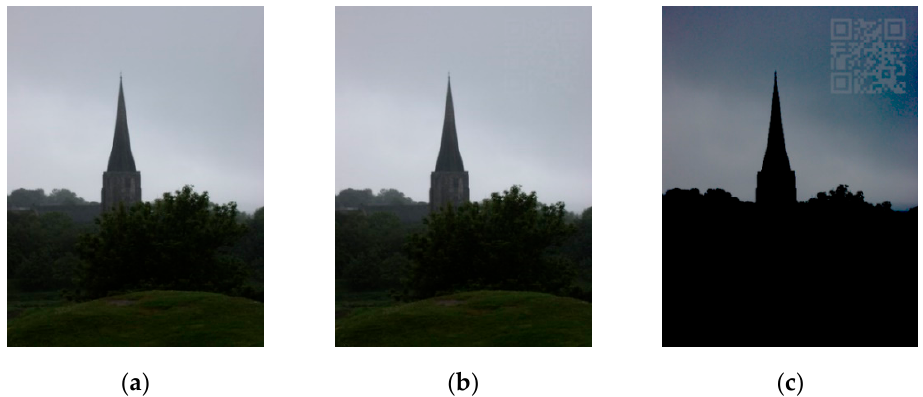
Figure 11. Sample set of images with QR code exhibited by the Shift GCF operation, γ = 0.3, ( a ) original image, ( b ) watermarked Image with PSNR = 50.41 dB, SSIM = 0.9964, NCD = 0.0113, ( c ) exhibited watermark.